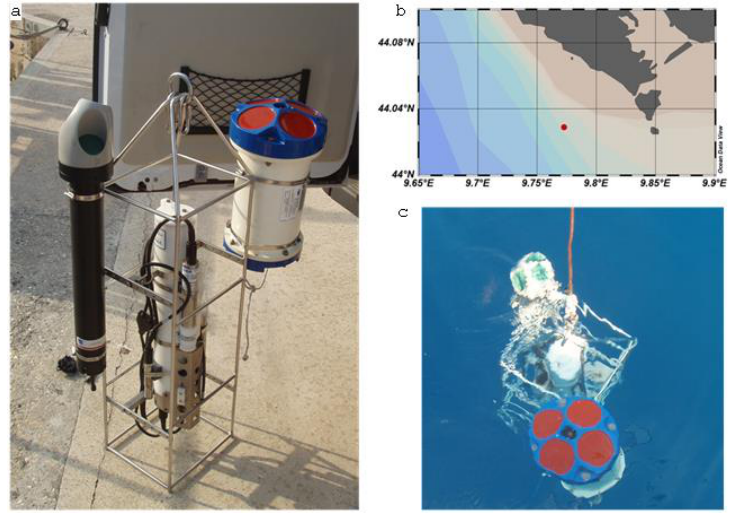
Figure 2. ADCPs comparison test: ( a ) mechanical mounting configuration; ( b ) working area (red dot: deployment point); ( c ) deployment.